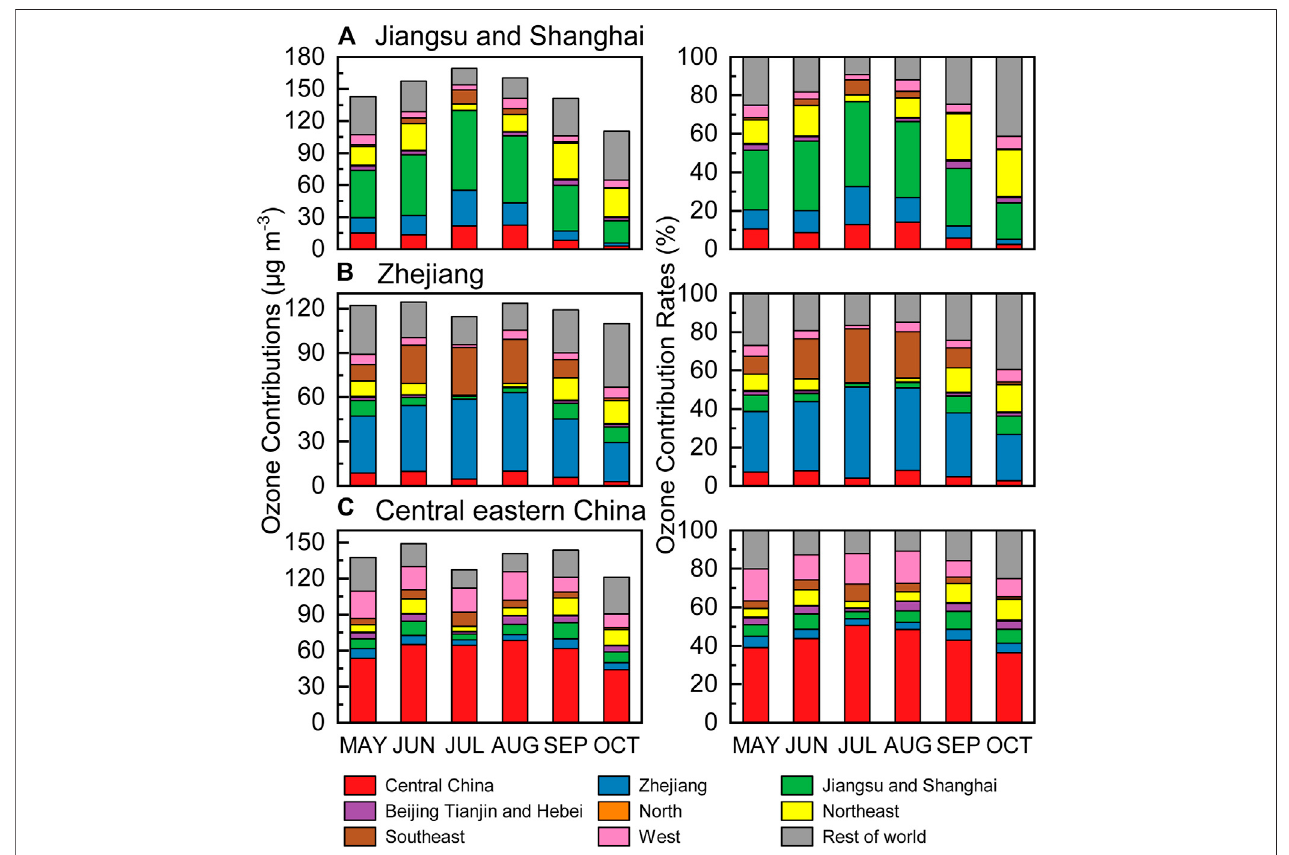
FIGURE 9 | Ozone contributions from different source regions to monthly mean surface ozone concentrations in three regions: (A) Jiangsu and Shanghai, (B) Zhejiang, and (C) central eastern China from May to October 2017.